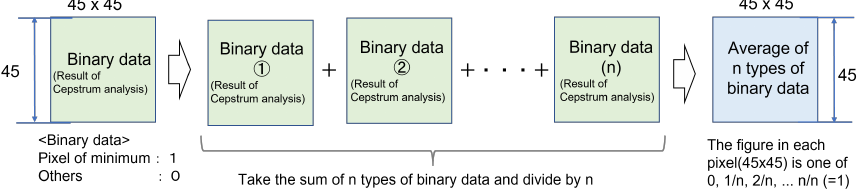
Figure 9. Procedure for checking the number and location of pixel of minimum in cepstrum analy- sis results.